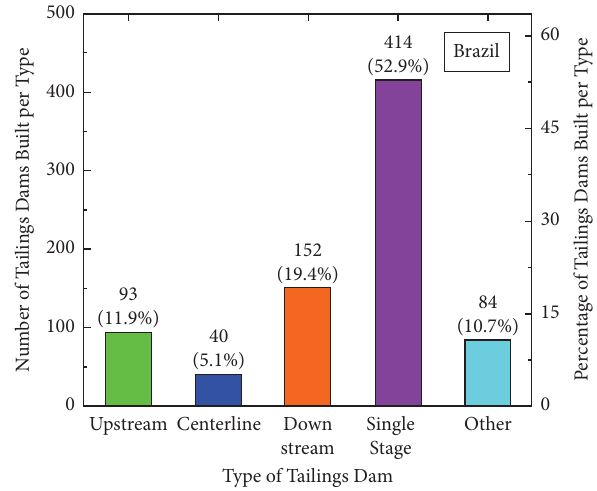
Figure 1: Number and percentage of tailings dams built per type in Brazil (data from Bowker [22] and Agˆencia Nacional de Mineracão [26]).